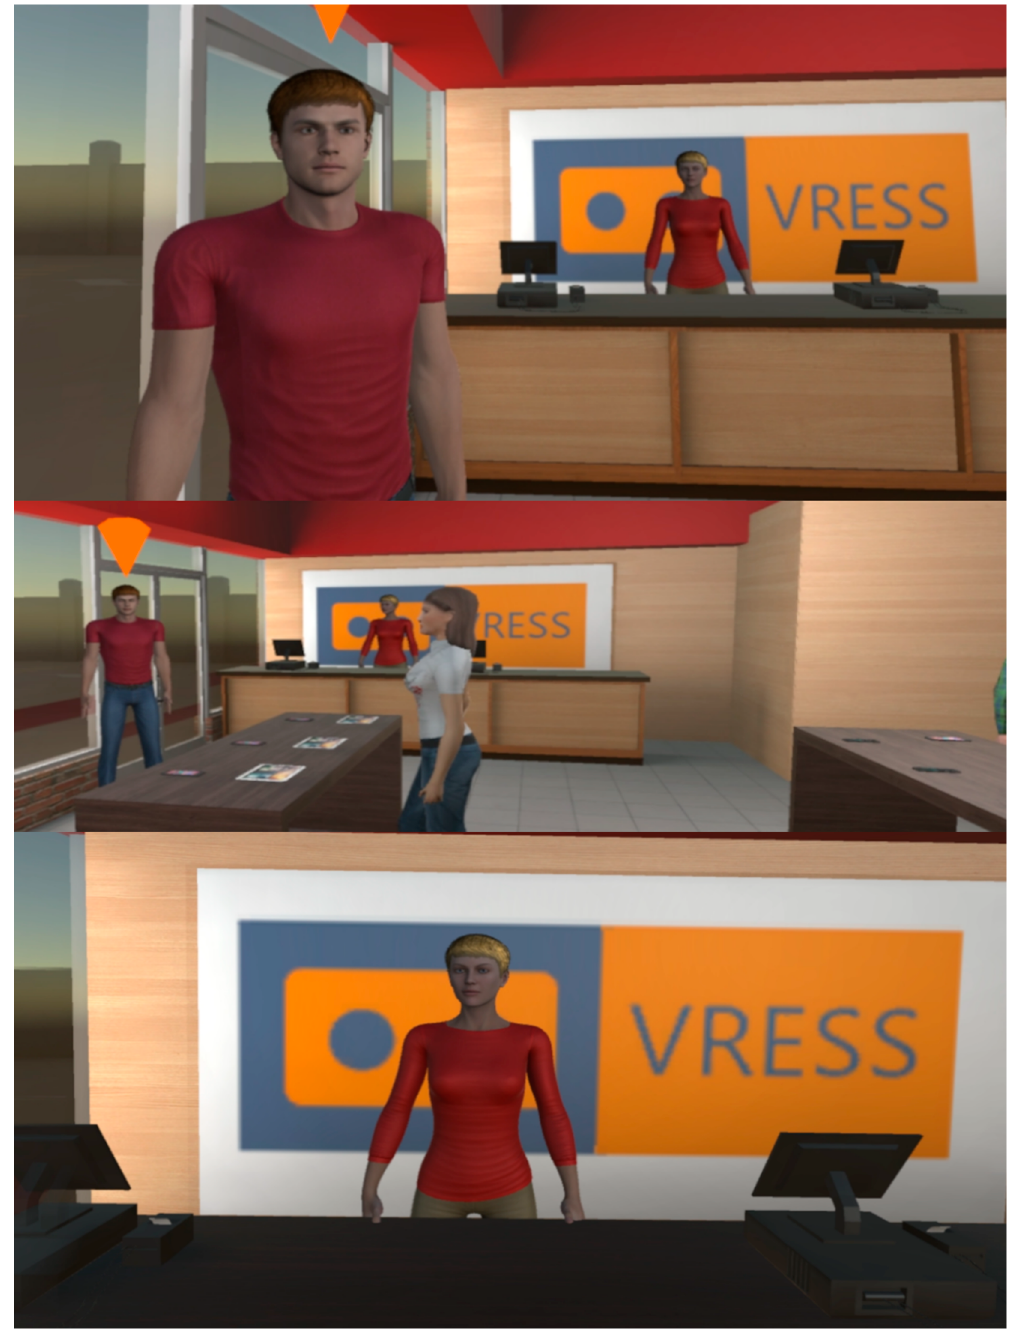
Figure 4. Customer service ( Top ), main area ( Middle ), and cashier ( Bo tt om ) of the store.